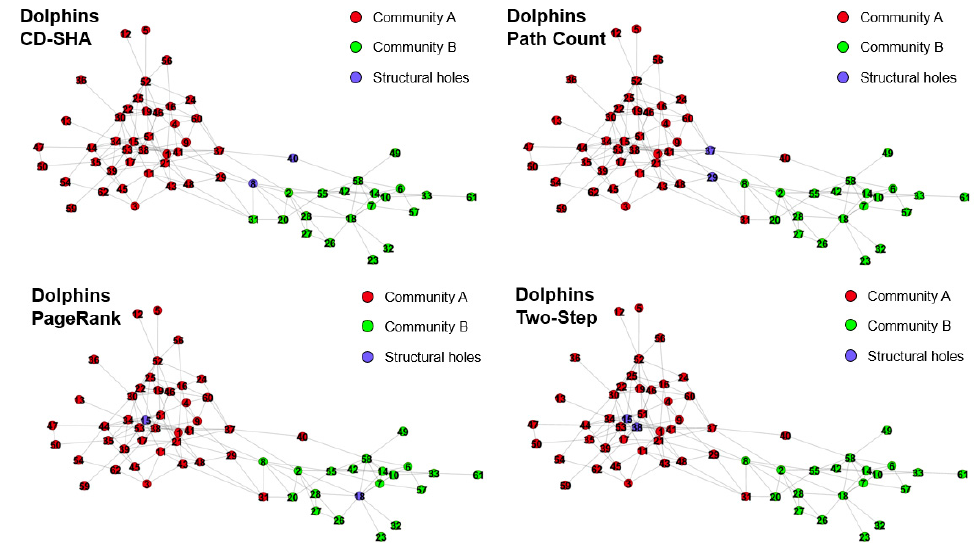
Figure 5. Structural holes in the dolphins’ networks detected by the CD-SHA algorithm, the Path Count algorithm, the two-step connectivity algorithm, and the PageRank algorithm.